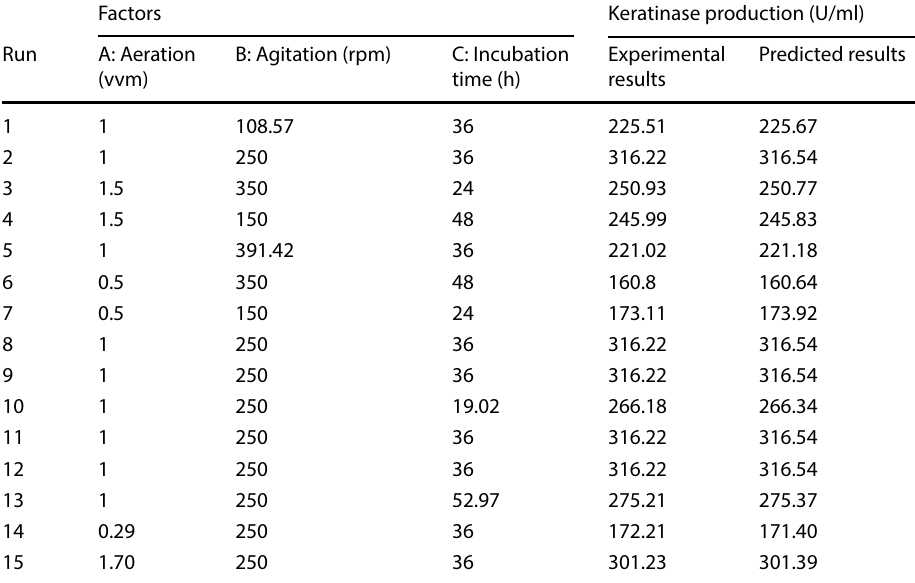
Table 2 Central composite rotatable design matrix for keratinase production by Bacillus aerius